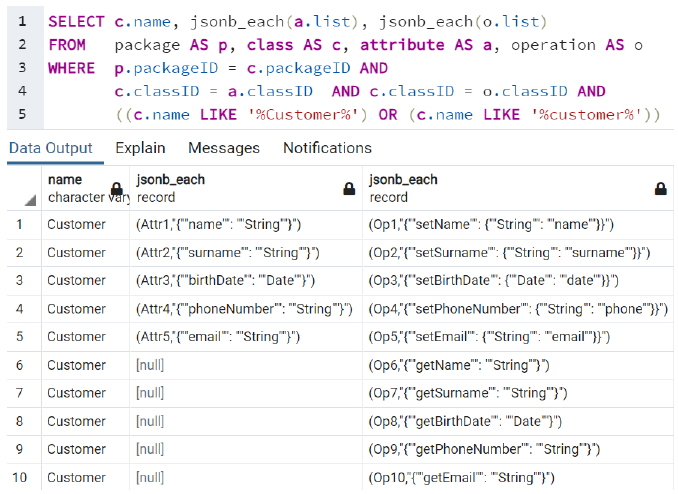
Figure A6. Query 5. It uses the PostgreSQL’s jsonb_each() operator. A not trivial inquiry concerns investigating the existence of hierarchies among tables in the class diagram of a given project. The complexity comes from the need to compute the transitive closure of all superclasses (if any) of a given instance of the class table (i.e., of a given instance of the UML element class of Figure 3). Recursive query Q6 implements such a request (Figure A7). As expected, there are no hierarchies among the classes of the class diagram of the case study.